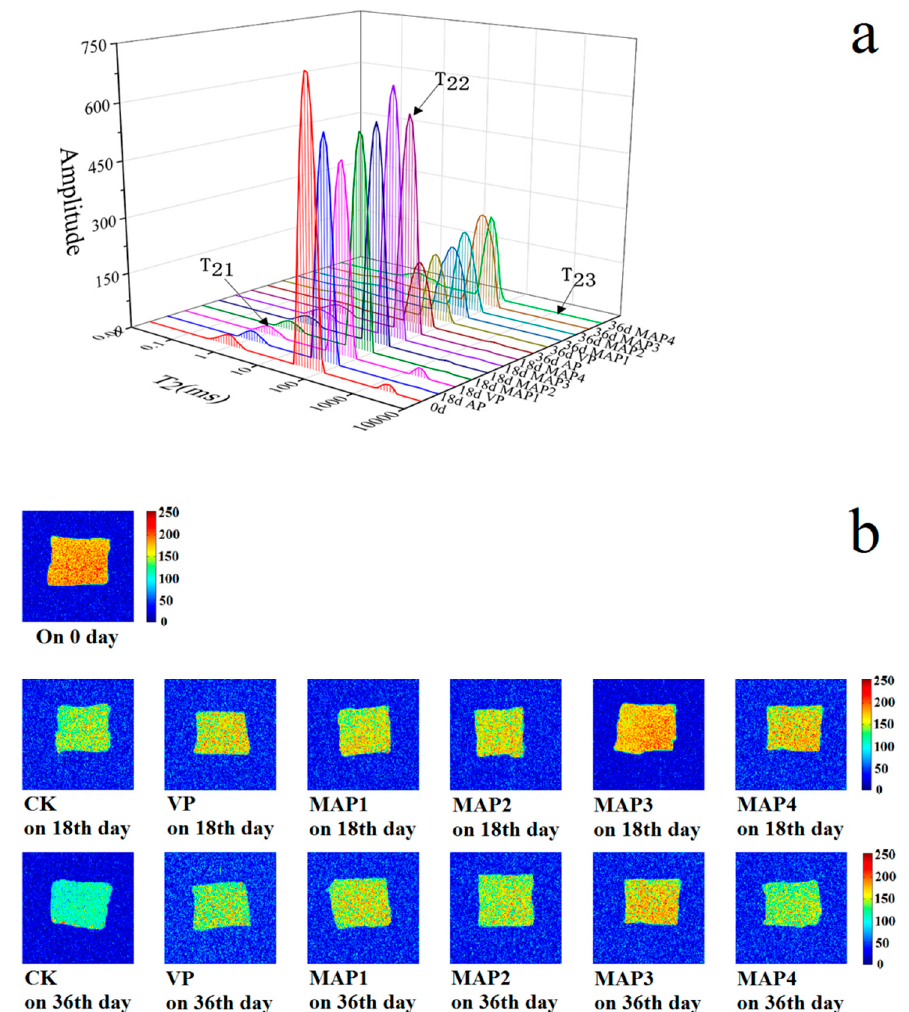
Figure 3. Changes in water distribution ( a ) and magnetic resonance imaging ( b ) of Chinese sea bass during superchilling storage at − 0.9 °C. AP: air package; VP: vacuum package; MAP1: modified atmosphere packaging with 40% CO 2 /60% N 2 ; MAP2: modified atmosphere packaging with 40% CO 2 /10% O 2 /30% N 2 ; MAP3: modified atmosphere packaging with 60% CO 2 /10% O 2 /30% N 2 ; MAP4: modified atmosphere packaging with 60% CO 2 /40% N 2 .